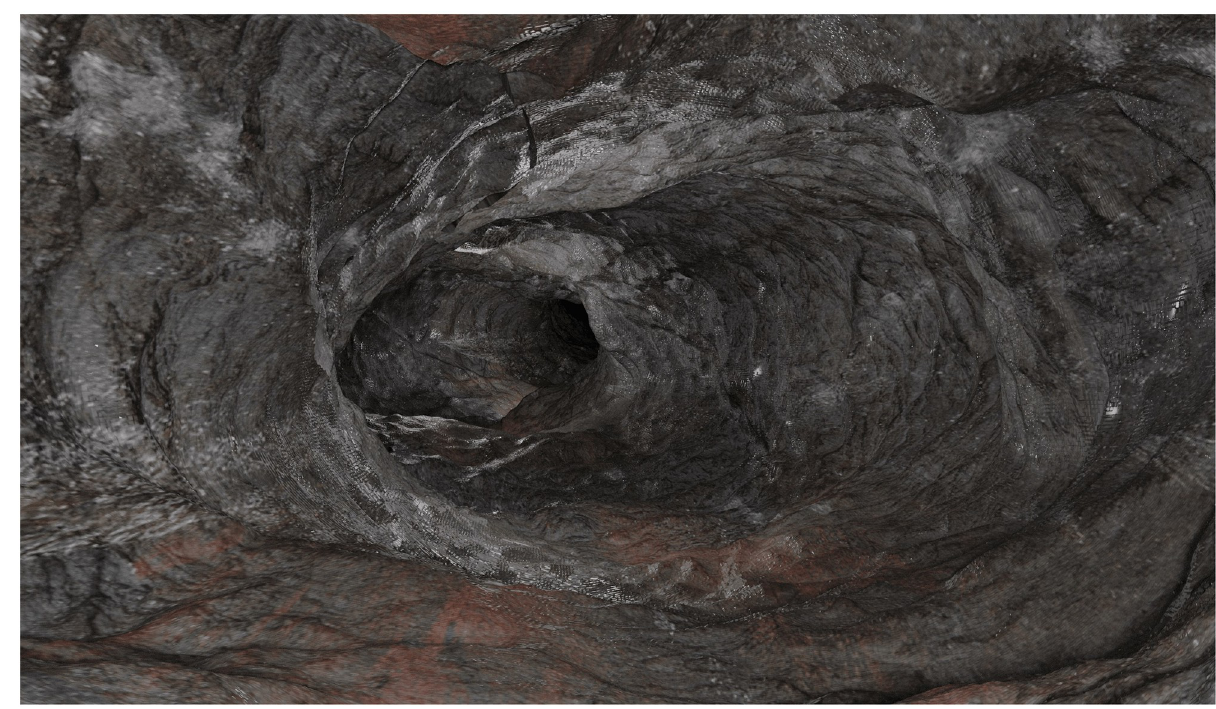
Fig 11. An example of a cave rendering. Colour, specularity and normal maps were applied. Colour maps are used from the walls of the Hillingdur and Bla´mi lava caves in Iceland obtained by Iakubivskyi. White spots indicate possible biological mats or secondary mineral precipitation; the red areas simulate iron oxide.